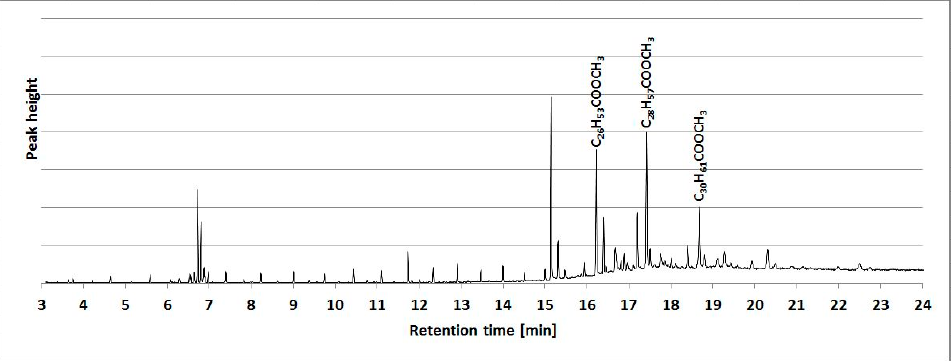
Figure 4. GC-MS chromatogram of product obtained by C30+ olefin oxidation using 2 equiv. of H 2 O 2 (Table 8, Entry 1a; mass spectra Figures S9–S12).